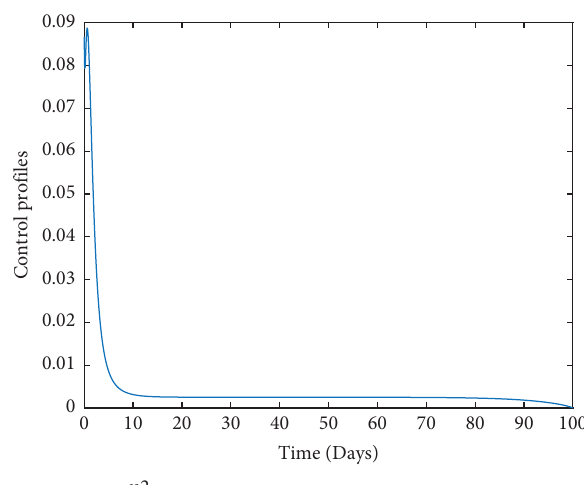
Figure 12: Diagram of the optimal solution u ∗